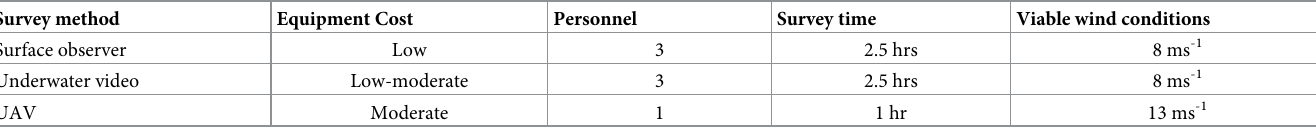
Table 3. Comparison of the cost effectiveness and logistical considerations for each turtle count method.